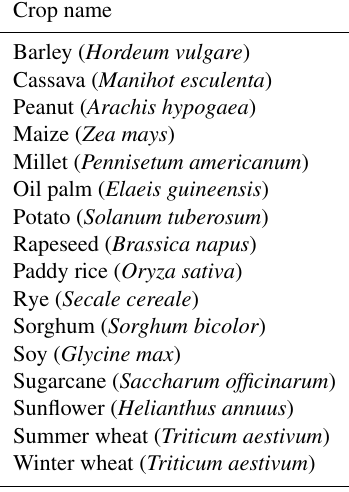
Table 3. List of all considered